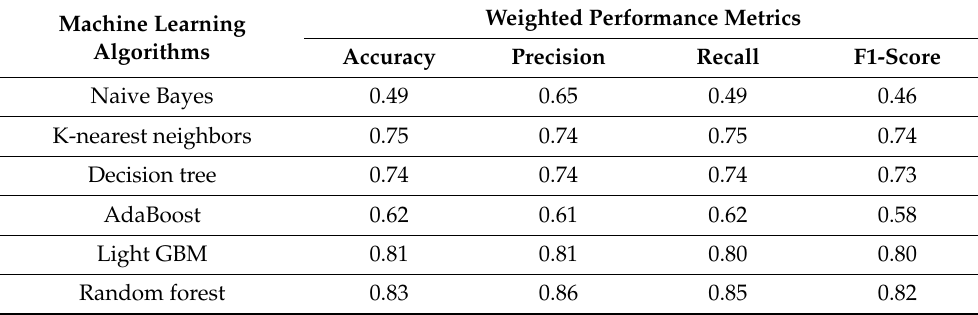
Table 3. Using stadium fire risk datasets for model fitting and selection of optimal